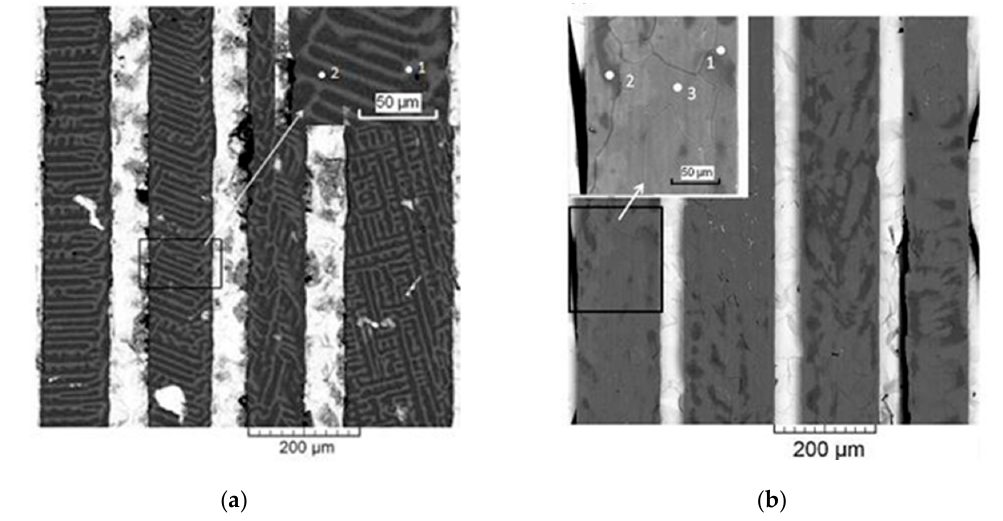
Figure 3. SEM-micrographs longitudinal sections of specimens with fibres crystallised with a crystallisation rate of ~250 mm/min, α = 0.021 ( a ) and <1 mm/min, α = 0.032 ( b ). The results of the X-ray microanalysis in the points shown in the micrographs are presented in Table 1. Table 1. Characteristics of the fibre microstructures and fracture toughness of oxide/molybdenum composites.